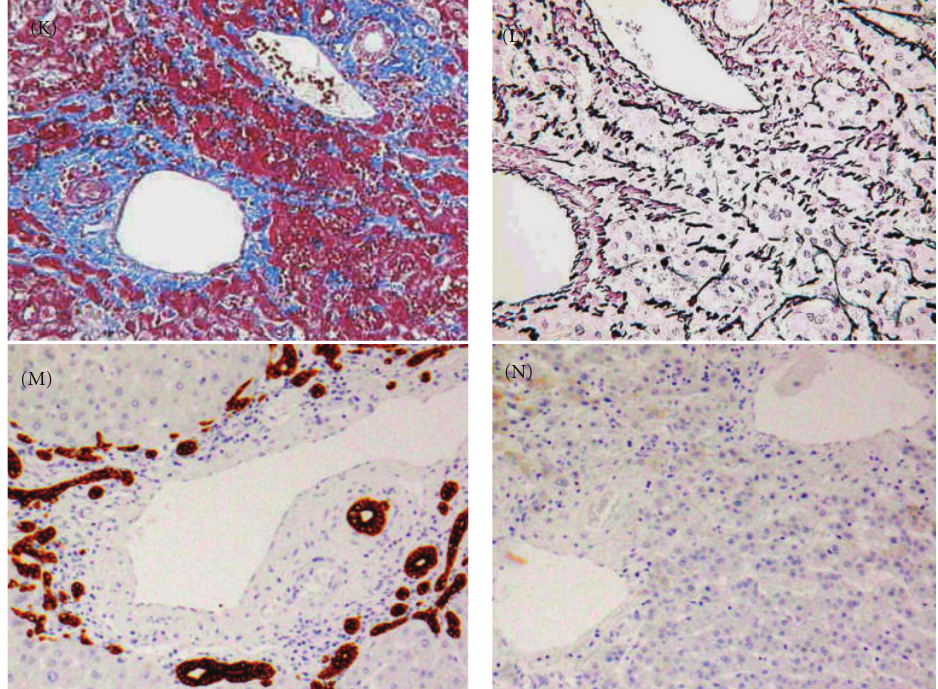
Figure 1: Various features of stromal invasion of hepatocellular carcinoma (HCC) and pseudo-invasion (A) Crossing type. Cancer tissue (HCC) invades across fibrous septa (f) of tumor nodule. (B) Longitudinal type. Tumor cells grow longitudinally within fibrous septa (arrowheads). (C) Irregular type. Portal areas are irregularly invaded by tumor cells (Masson trichrome stain). (D) A non-cancerous area without invasion, and a portal area and fibrous septa are clearly seen. (E) Pseudo-invasion. Benign non-cancerous cells are found in the fibrous stroma (Masson trichrome stain). (F) Macroscopic view of stromal invasion. In the non-cancerous area without invasion (area of (a)), fibrous septa are clearly seen. In the area of tumor spread (area of (b)), septa are indistinct. (G) A panoramic view of stromal invasion. In the same way as in (F), the non-cancerous area without invasion (area of (a)) shows distinct fibrous septa. The area of tumor spread (area of (b)) shows indistinct septa because stromal invasion of longitudinal type and irregular type ((B), (C)) reduced the amount of fibrous component. (H) Continuity of fibrous invasion and vascular invasion. The arrows show portal vein (p) invasion. Vascular invasion is continuous to stromal invasion of fibrous tissue of the portal “tract” and fibrous septum (Masson trichrome stain). (I) Masson trichrome staining of pseudoinvasion. (J) Silver staining of the same specimen as (I). Liver cells are clearly surrounded by reticulin fibers. (K) Masson trichrome staining of true invasion. (L) Silver staining of the same specimen as (K). Carcinoma cells are not surrounded by reticulin fibers. (M) (N) Cytokeratin (CK) 7 immunostaining in a non-cancerous area (M) and cancerous area (N). (M) Ductular reaction, confirmed by CK 7 staining, is clearly seen in a non-cancerous, non-invasive area. (N) Ductular reaction is not found in the invasive area. (N) Adapted from Y. Kondo et al. [2], F. Kondo et al. [3], and from F. Kondo [11].